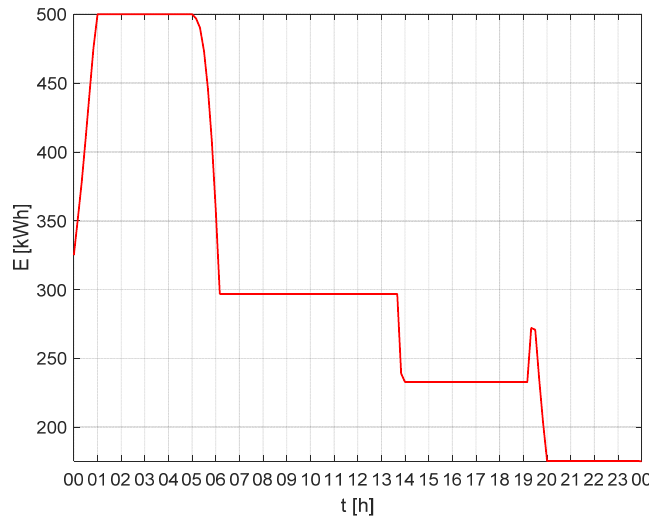
Figure 20. Results of the simulation of the operation of the private network with the BESS with real characteristics for the set exchange power according to the curve, variable in the range PM 300–600 kW; change of energy accumulated in the BESS over time.